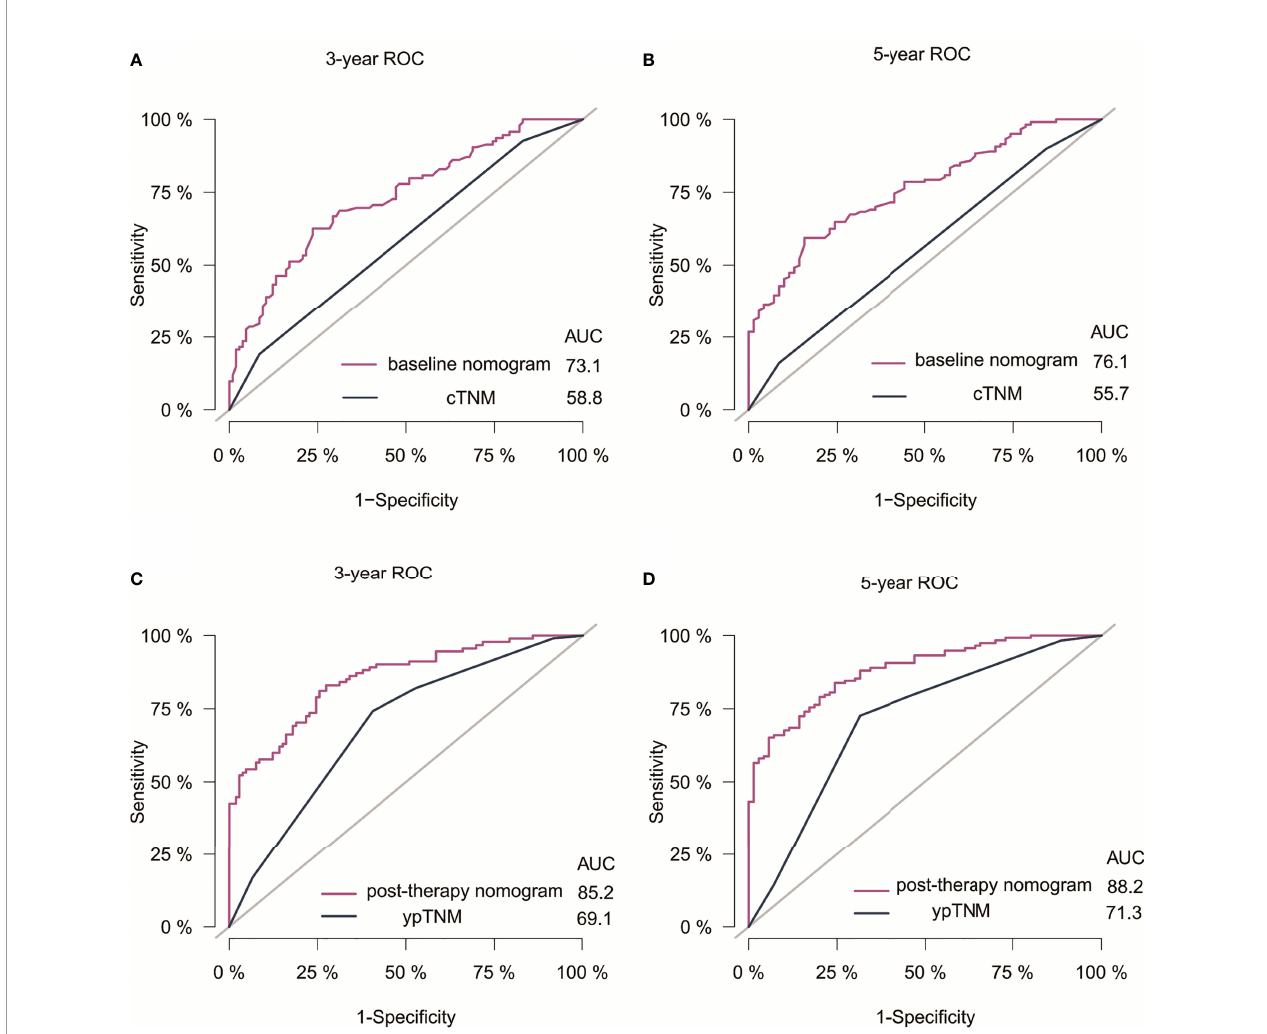
FIGURE 3 | ROC of nomograms and the AJCC staging system for 3- and 5-year DFS prediction in Siewert Type II/III AEG patients. (A) 3-year ROC for baseline nomogram and cTNM staging. (B) 5-year ROC for baseline nomogram and cTNM staging. (C) 3-year ROC for post-therapy nomogram and ypTNM staging. (D) 5-year ROC for post-therapy nomogram and ypTNM staging. Receiver operating characteristic curves; AUC, Area under the